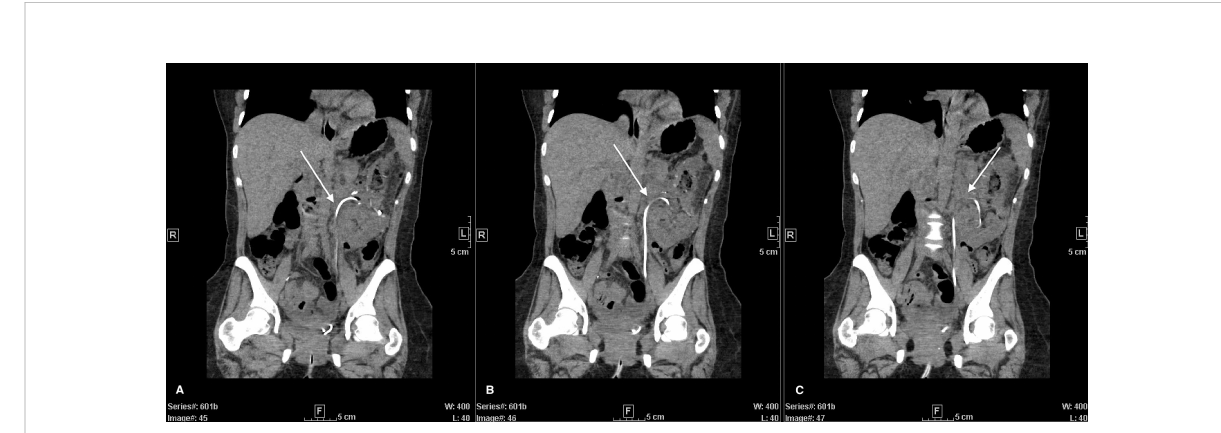
FIGURE 2 Post left partial nephrectomy CT-abdomen with IV contrast. Coronal view of 3 continuous images from left to right (A – C) . Ureteral stent (white arrows) displaying continued arching trajectory superiorly despite removal of